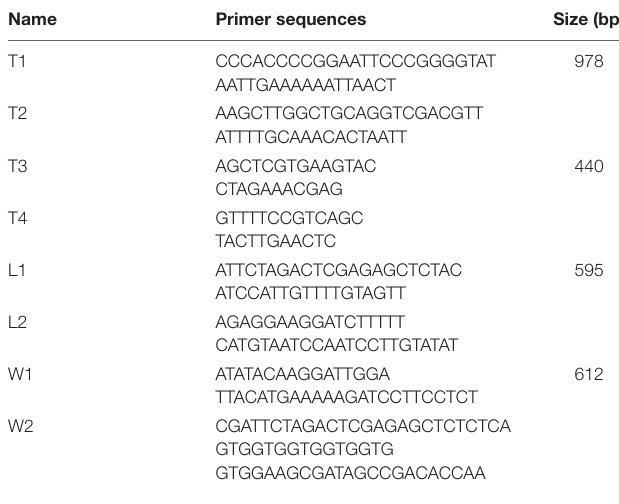
TABLE 1 | Primers used for construction the recombinant